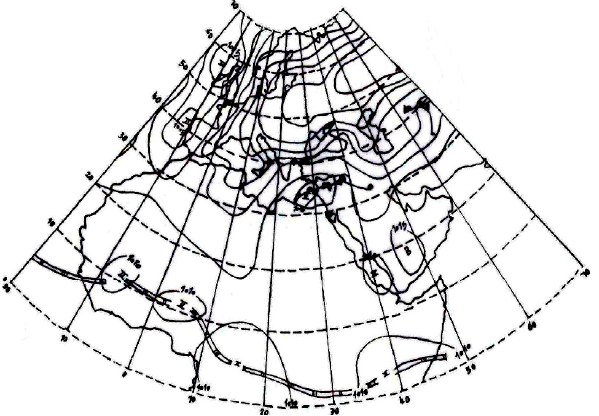
Fig. 10 The pattern of the surface Siberian HP isobars (AAXX) and low pressure center 48 hours before the heavy rainfalls (Type III: 15 February 1988)